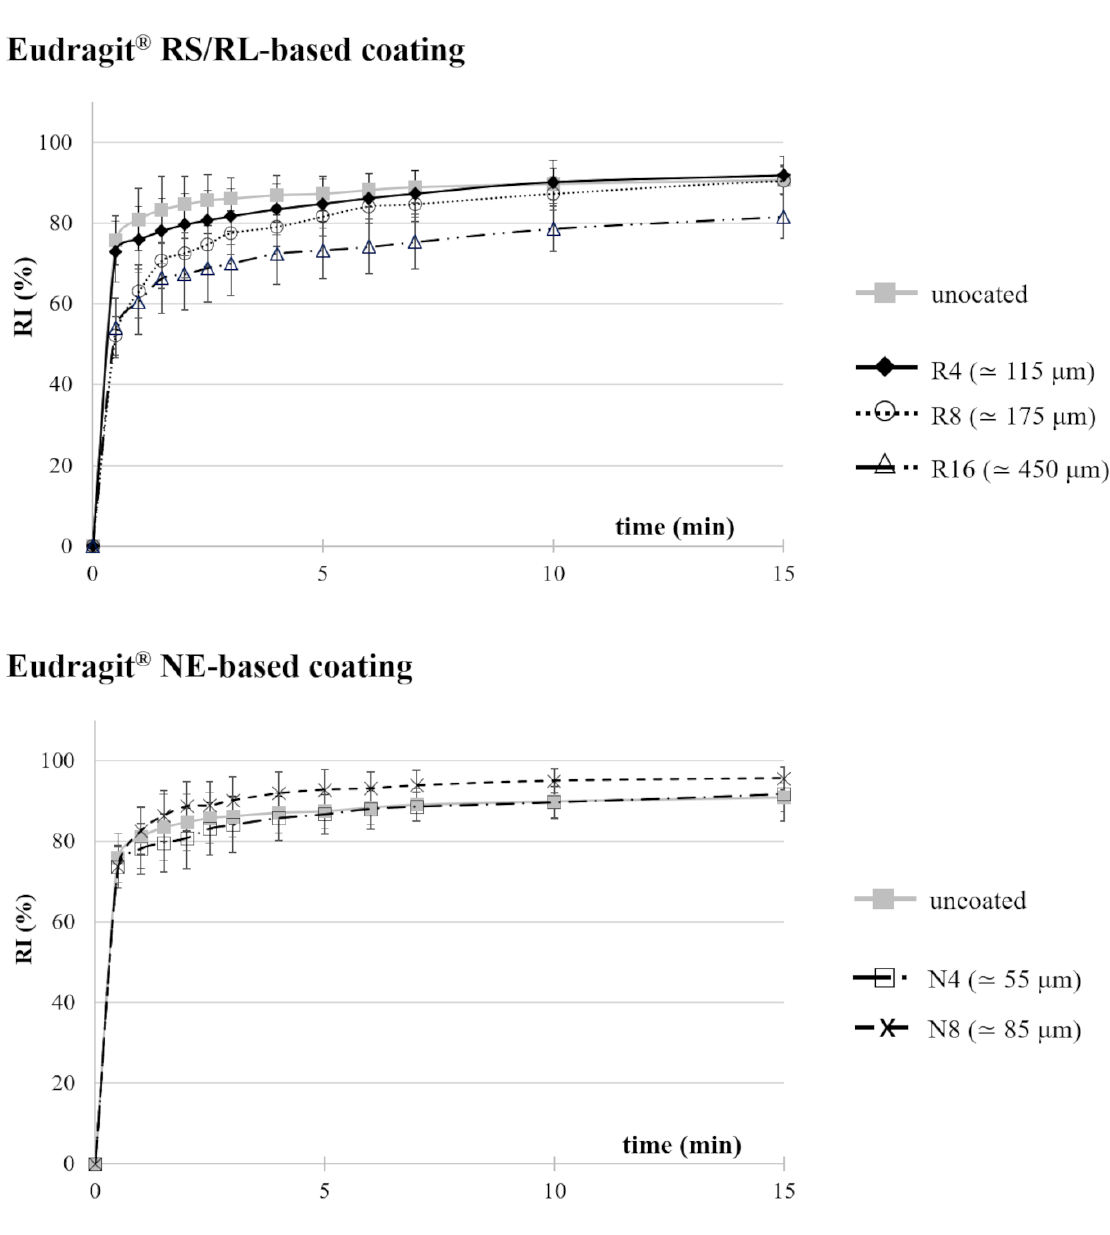
Figure 12. RI versus time curves relevant to I-shaped samples coated with different formulations.